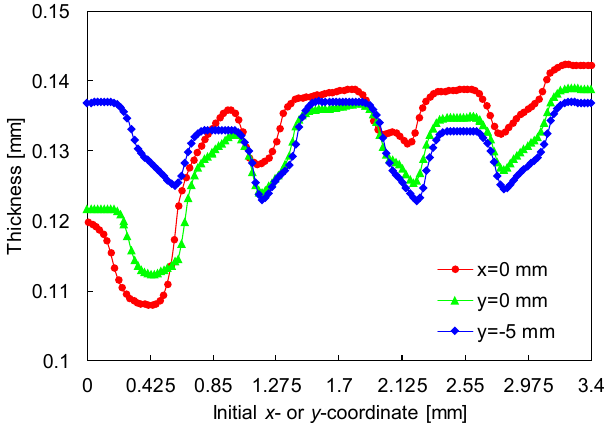
Figure 26. Thickness distribution in three different localizations of the flow channel considering w 1 = 1.4 mm, s = 1.6 mm, r = 0.4 mm, R = 0.5 mm, and h = 0.7 mm.